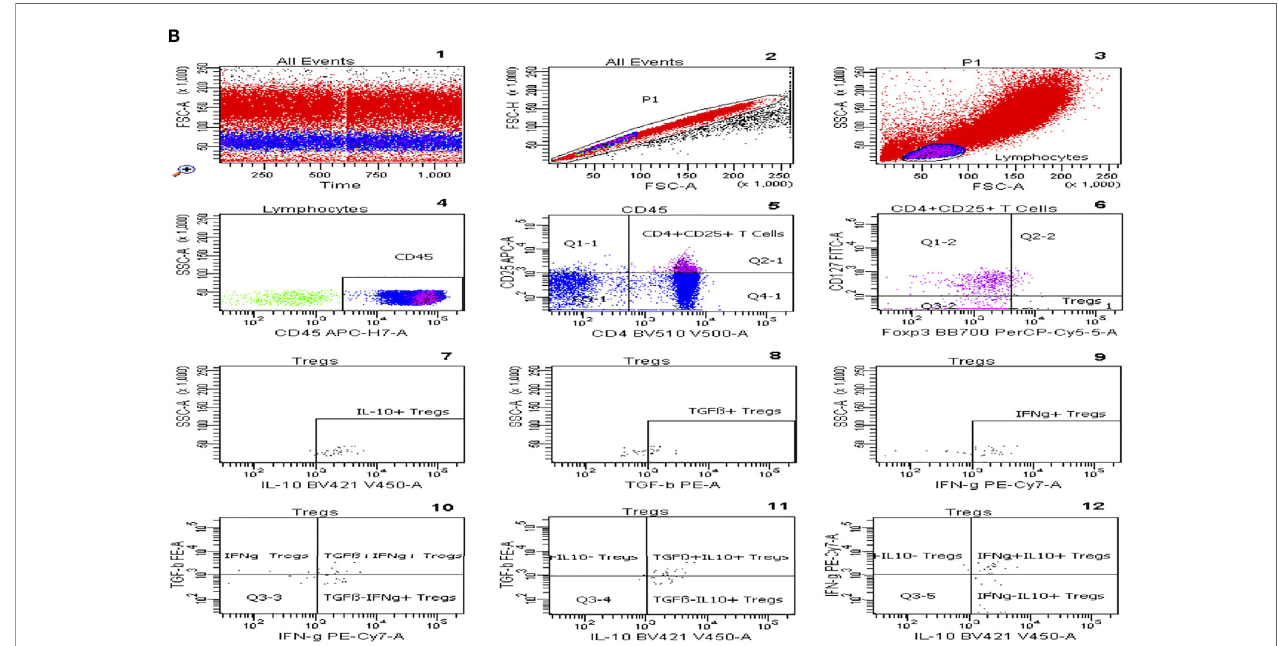
FIGURE 1 | (A) Gating strategy of CD8+CD28- Tregs, IL-10+ Bregs, and perforin+ and/or granzyme B+ CD8+ T cells. After ensuring the stability of the run, selection of singlets and gating of lymphocytes according to their size (1-3), T-lymphocytes were gated based on CD45 vs CD3 plot, CD8+CD28- Tregs were then selected and their subsets, Foxp3+, TGF- b +, IFN-g+ and IL-10+, were gated respectively (4-9). CD8+ T cells are gated out of T cells and then Granzyme B+ and Perforin+ CD8+ T cells were selected (10-14). IL-10+CD19+ regulatory B cells are gated out of CD45+ cells (15,16). (B) Gating strategy of CD4+CD25+CD127- Foxp3+ Tregs: Graph 1 includes all events analysed in the tube. Graph 2 exhibits the exclusion of doublets. Graph 3 shows FSC vs SSC dot plot and gating of lymphocytes according to size, CD45 vs SSC dot plot permits elimination of debris and focuses on lymphocytes (Graph 4), CD25 vs CD4 dot plot allows the identi fi cation of CD4+CD25+ T lymphocytes (Graph 5), the Foxp3+CD127- cluster was gated out of CD4+CD25+ lymphocytes and identi fi es Tregs (graph 6). In addition, graphs 7-12 show Treg subsets gated out of total